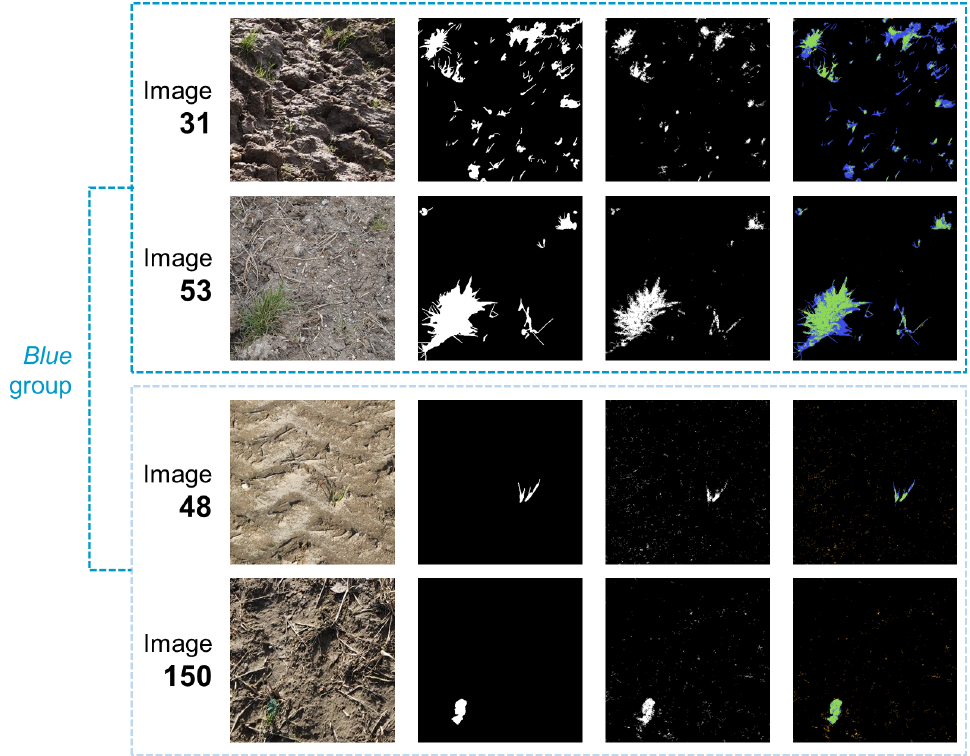
Figure 8. The representative images shown in Figure 6b with their GT, detection, and comparison masks showing the TP, FN, and FP